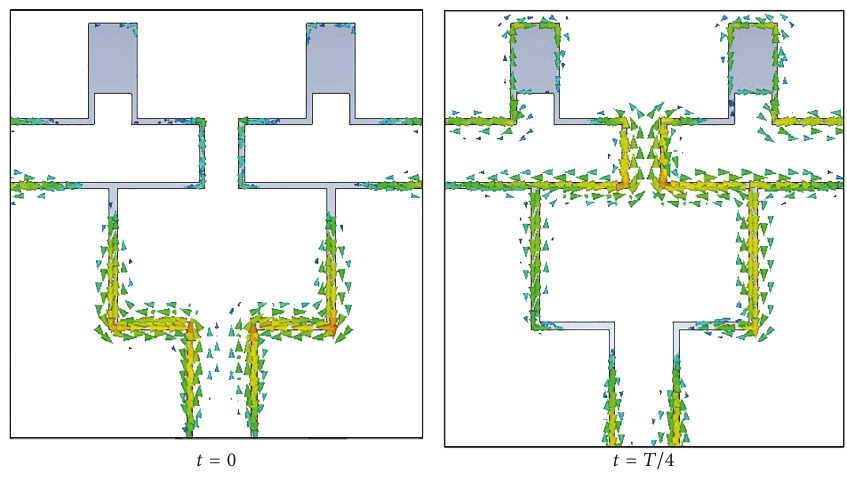
Figure 3: The simulated current distributions under the optimized structure.